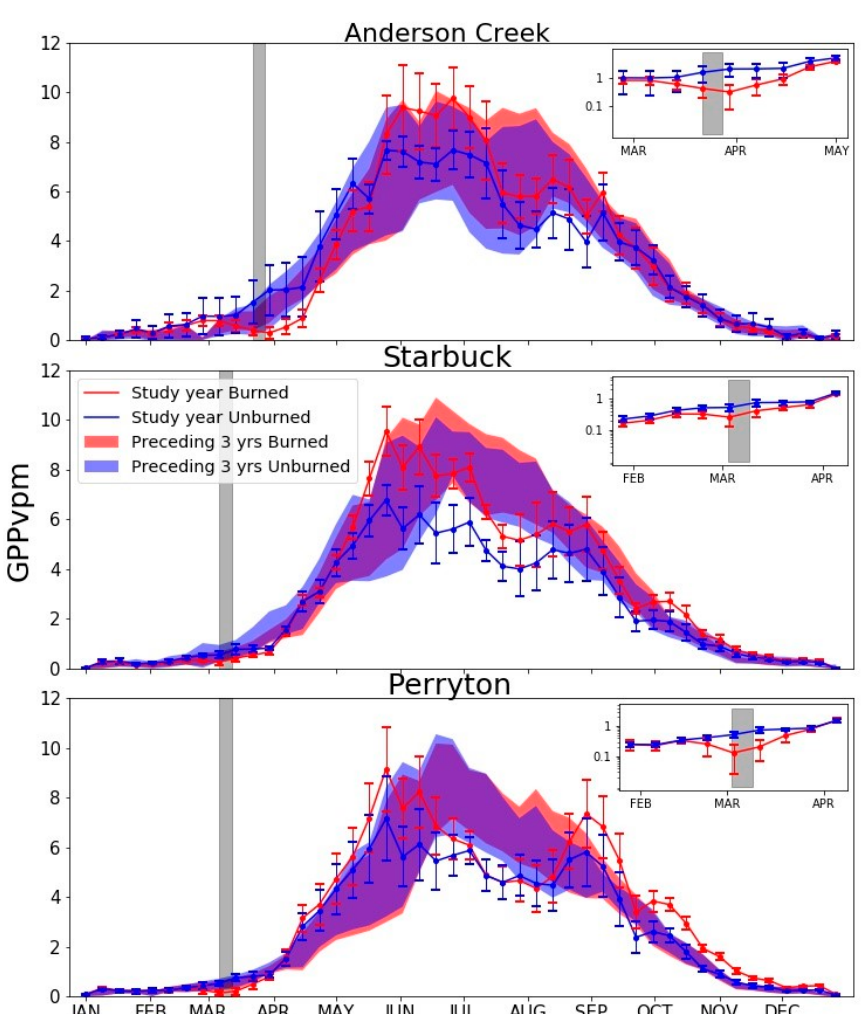
Figure 5. Three year average Gross Primary Productivity (GPP) values as calculated following Zhang et al. (2017) for the unburned plots (blue shaded) and burned plots (red shaded) of the Anderson Creek (top), Starbuck (middle), and Perryton (bottom) wildfires. Fire-year GPP averages for the unburned (blue) and burned (red) plots are shown as solid lines with error bars of one standard deviation. Time of fire is marked by grey shaded columns.